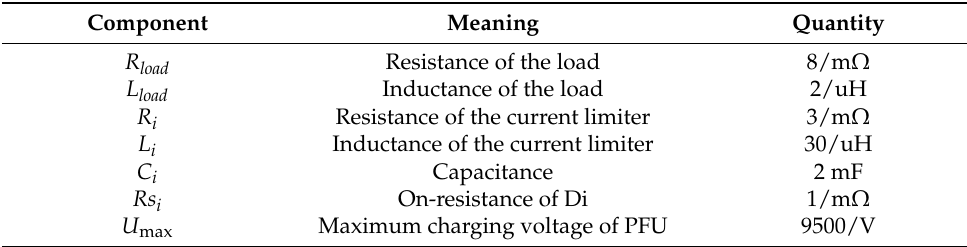
Table 1. Parameters of the circuit.